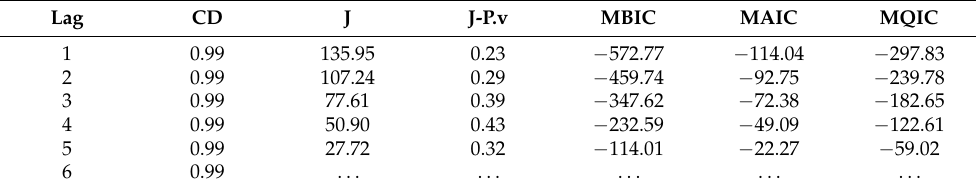
Table A2. Lag selection criteria.